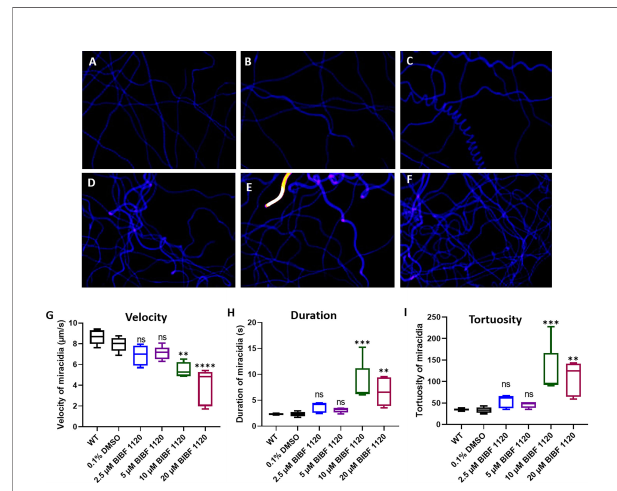
FIGURE 9 | Behavioral changes in S. mansoni miracidia hatched from liver eggs treated with BIBF 1120. The behavior of miracidia hatched from WT eggs and eggs treated with 0.1% DMSO or BIBF 1120 at concentrations of 2.5 m M, 5 m M, 10 m M, and 20 m M was determined. Heatmaps (A – F) represent the movement patterns of individual miracidia within a 1 min recording. Colors in the heatmaps (A – F) show the time miracidia spent at a speci fi c position. Black: absence; Blue: shorter time presence; Yellow and Red: longer time presence. Boxplots showing (G) velocity (H) duration, and (I) tortuosity of miracidial movement. (ns, not signi fi cant; ** p value ≤ 0.01; *** p value ≤ 0.001; **** p value ≤ 0.0001; One-way